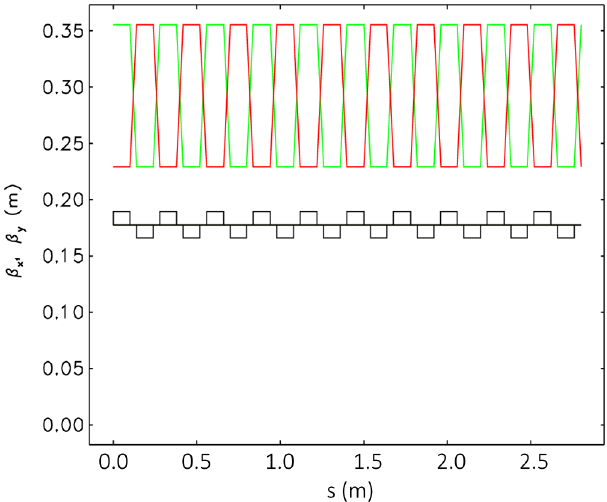
FIG. 1. Horizontal and vertical betatron function in the pro- posed FODO channel. Beam energy is 150 MeV. Quadrupole magnets ’ field gradient is 50 T = m over a magnetic length of 0.1 m. The magnetic field at the quadrupole ’ s bore radius of 10 mm is 0.5 T. The magnets are separated by 0.04 m.